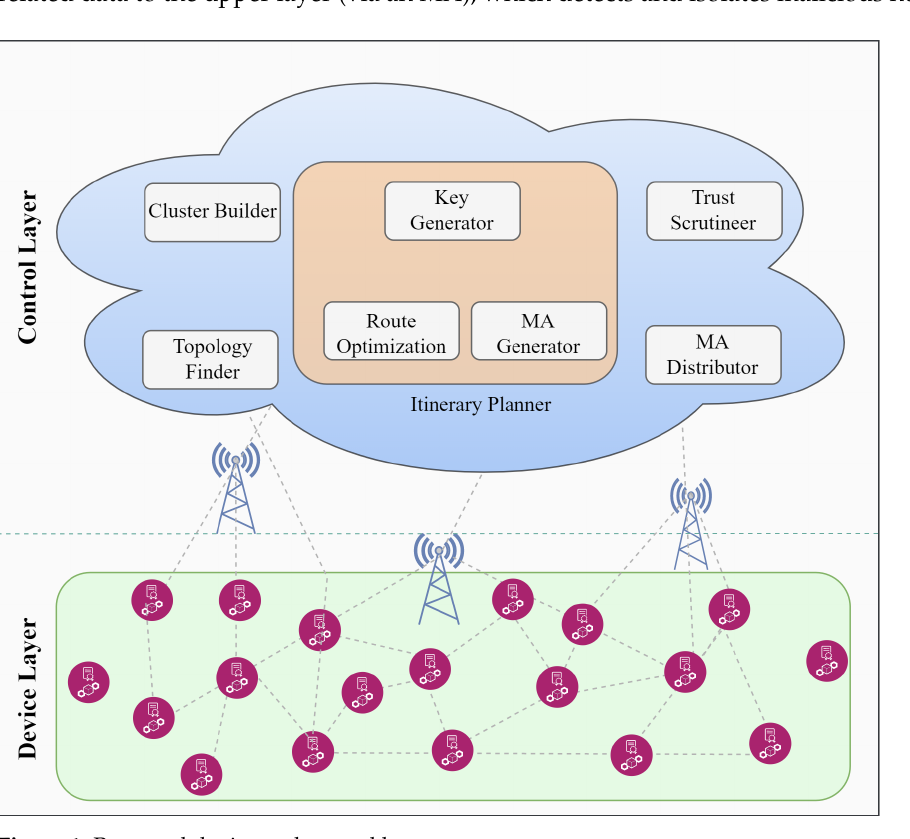
Figure 1. Proposed device and control